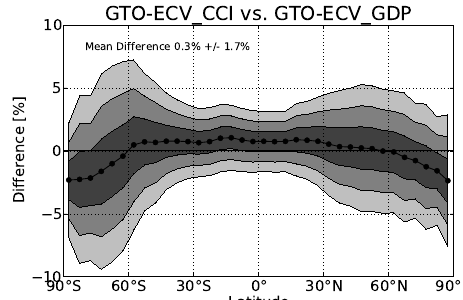
Figure 14. Percentage differences between GTO-ECV CCI and GDP 1 ◦ × 1 ◦ monthly means 1996–2011 binned into 5 ◦ latitude belts (black dots). The grey shading denotes the 1-, 2-, and 3- σ stan- dard deviations, respectively.